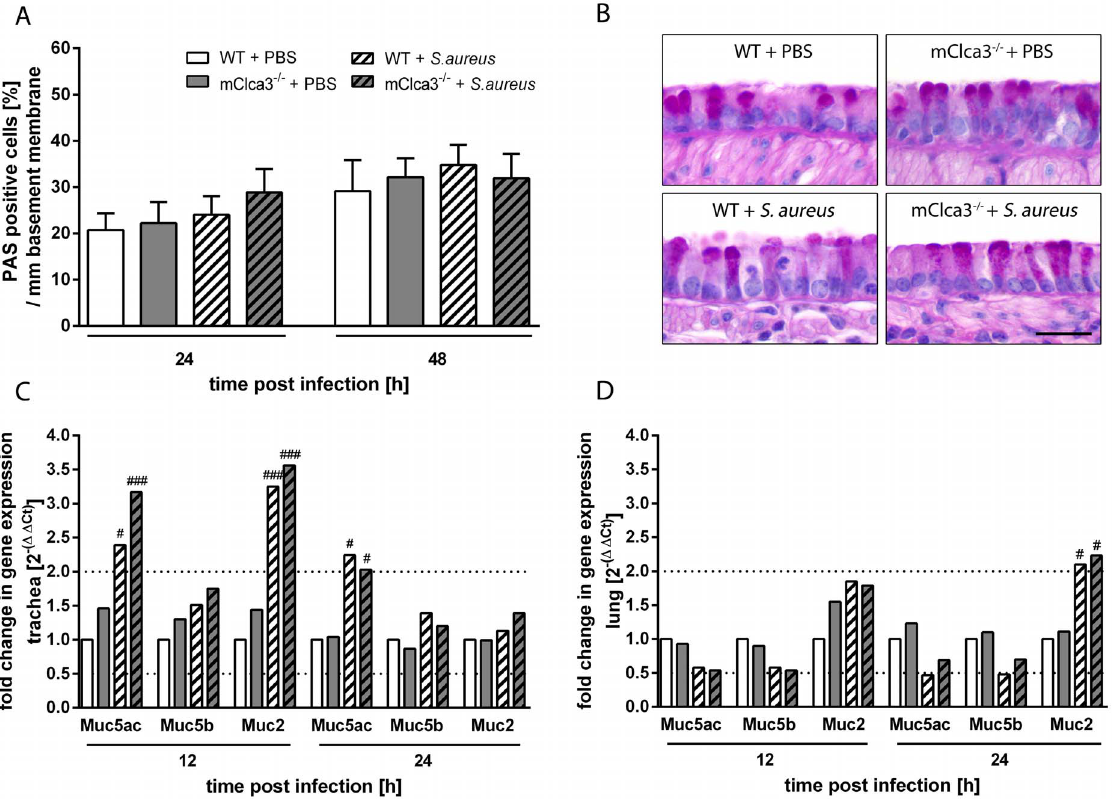
Figure 7. mCLCA3-deficiency had no influence on mucus cell number and mucin expression in infected mice. (A) Mucus cells were quantified by calculating the percentage of periodic acid Schiff (PAS)-positive cells per mm basement membrane. (B) No differences in number or distribution of mucus cells were observed in S. aureus infected or uninfected mice. (C, D) Expression levels of Muc5ac, Muc5b and Muc2 were quantified at indicated time points in trachea and lung by RTq-PCR. Dotted lines indicate fold change of 0.5 and 2, respectively, as limit for valid statement of lowered and elevated parameters. Values are given as mean 6 SEM (n=4 each group (A, B), n=8 each group (C, D)). # p , 0.05, ## p , 0.01, ### p , 0.001, versus the PBS control group. Bar (B), 20 m